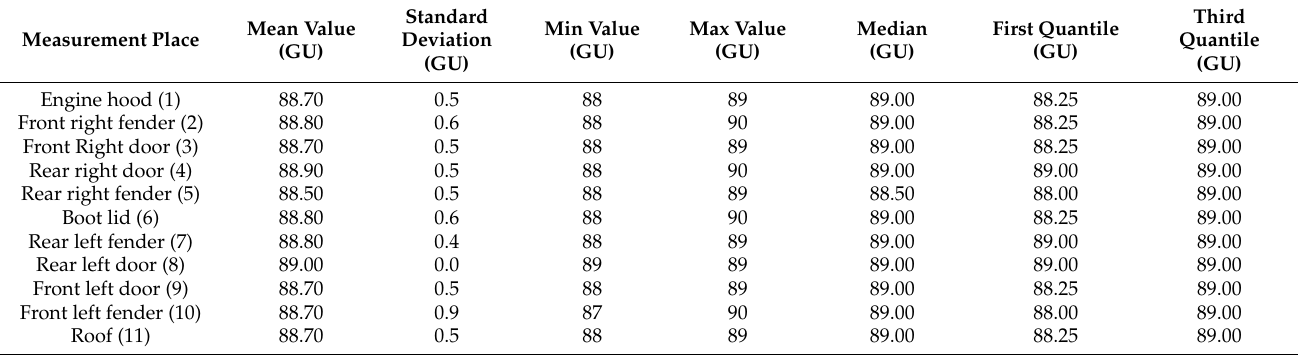
Table 4. The results of the measurements of the coating gloss (20 ◦ ) of the delivery vehicle. Measurement Place